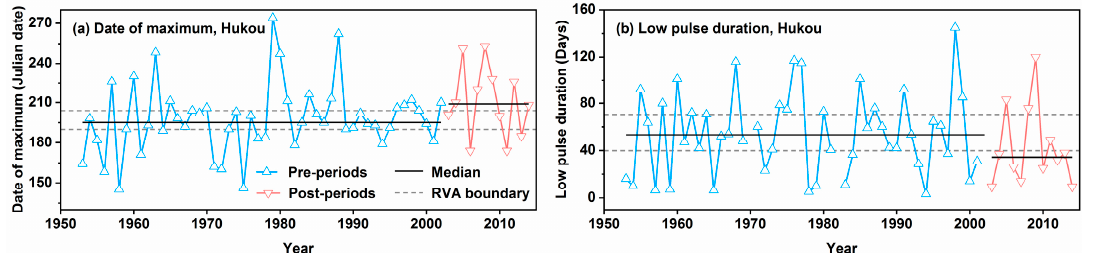
Figure 4. Variation of ( a ) date of maximum water level and ( b ) low pulse duration at Hukou.